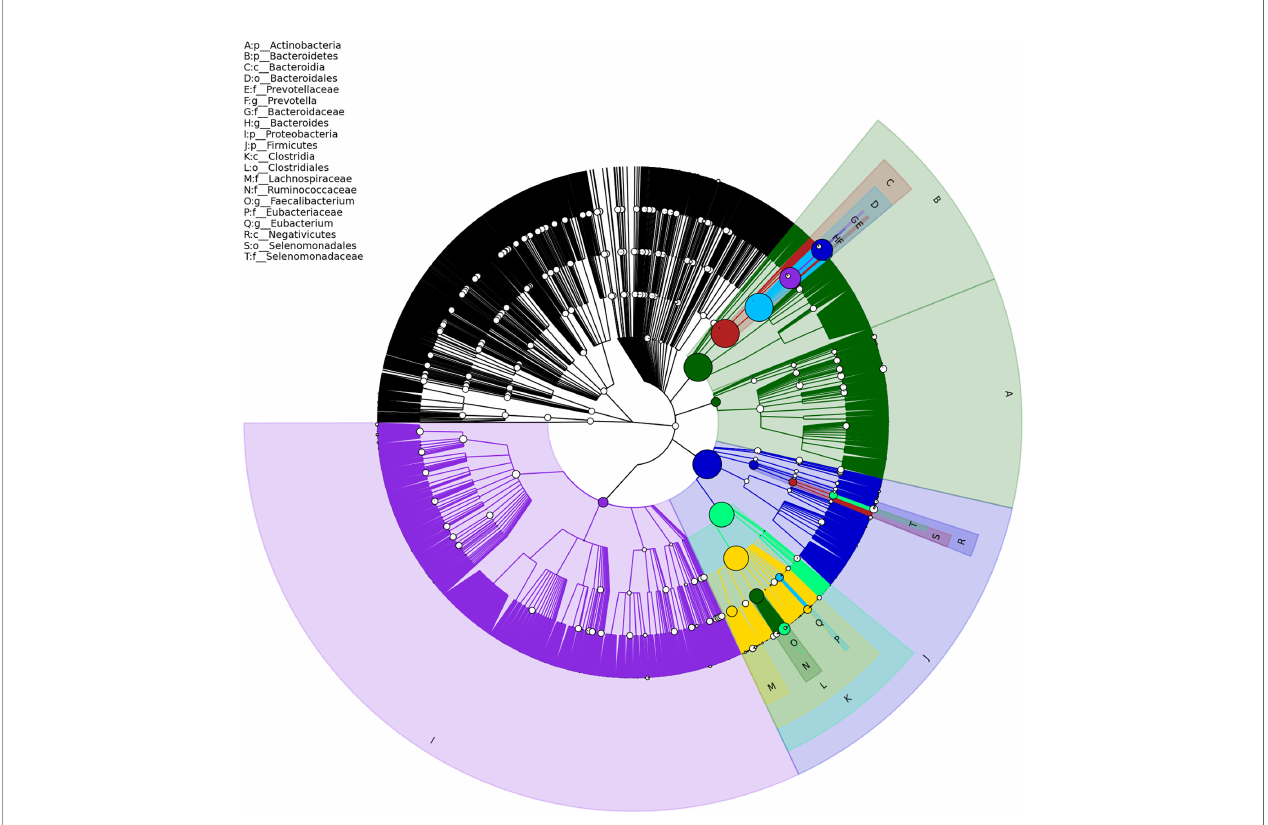
FIGURE 1 | Structure of gut microbial communities inPCa patients. Taxonomic hierarchy tree using GraPhlAntool displayedthe overallstructure of gut microbial communities in PCa patients fromphylumto species (outer to inner circle). The node size represented the relative abundance ofthe taxon. The top 20 taxa were